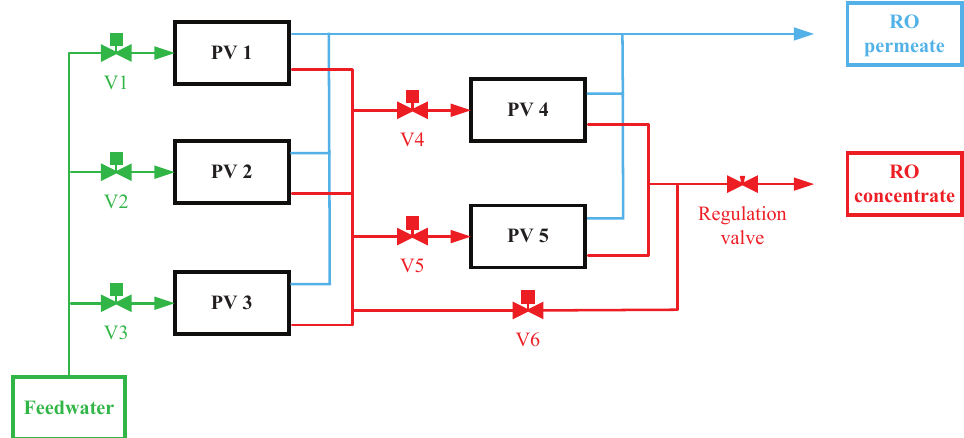
Figure 1. Brackish water reverse osmosis (BWRO) desalination